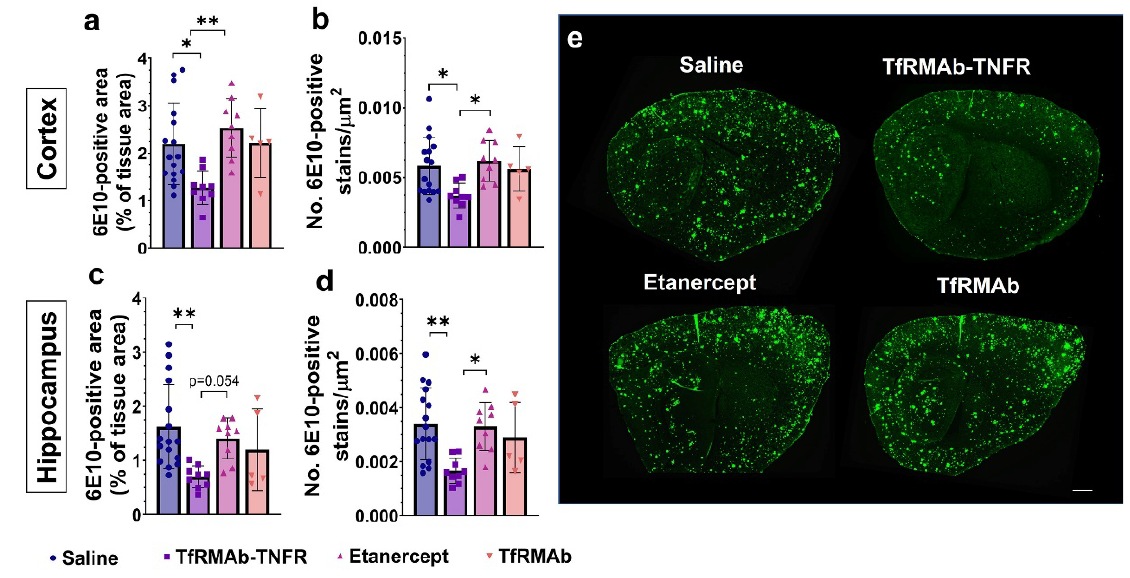
Figure 1. Effect of TfRMAb-TNFR dosing on 6E10-positive A β load. Cortical 6E10-positive A β area ( a ) and puncta number ( b ) were significantly lower in the TfRMAb-TNFR-treated mice compared to the saline-treated mice. There was a significant reduction in the hippocampal 6E10-positive A β area ( c ) and puncta number ( d ) in the TfRMAb-TNFR-treated mice compared to the saline-treated mice. Etanercept-treated mice had a higher 6E10-positive area and puncta number in the cortex and a higher puncta number in the hippocampus compared to the TfRMAb-TNFR-treated mice. 6E10-positive A β stains are shown in the representative sagittal brain section images in ( e ). Scale bar = 200 µ m. Data are presented as mean ± SD of n = 5–16 per treatment group, and data were analyzed using the one-way ANOVA with the Holm Sidak’s post hoc test. * p < 0.05, ** p < 0.01 for the indicated comparisons.